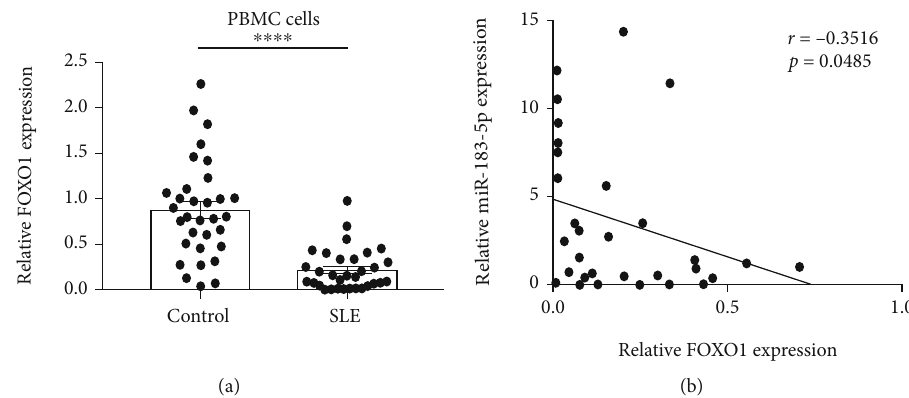
Figure 9: Expression of Foxo1 in subjects and with miR-183-5p levels (a) Foxo1 amounts are reduced in SLE cases ( n = 32 ) in comparison with healthy controls ( n = 32 ). (b) Spearman ’ s rank correlation revealed a negative relationship between Foxo1 amounts and miR-183-5p expression levels. ∗ p < 0 : 05 ; ∗∗∗∗ p < 0 : 0001